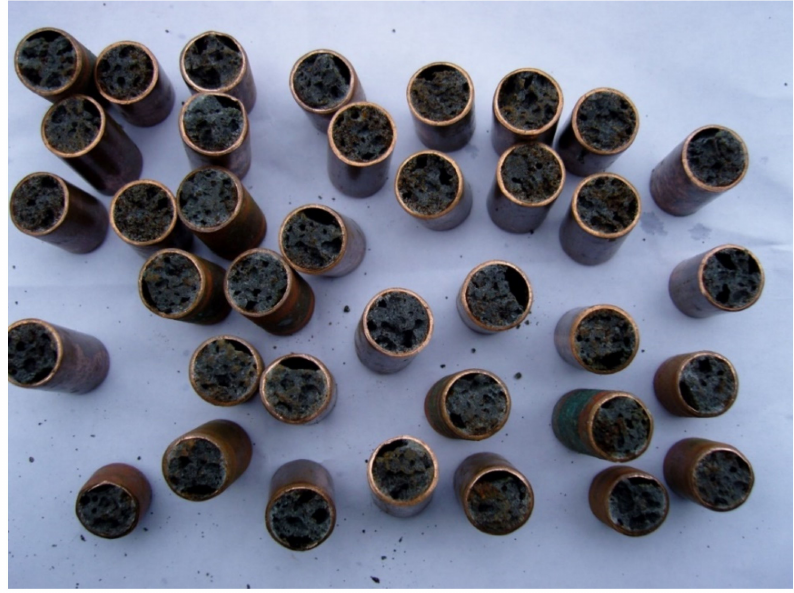
Figure 6. Example set of desalination